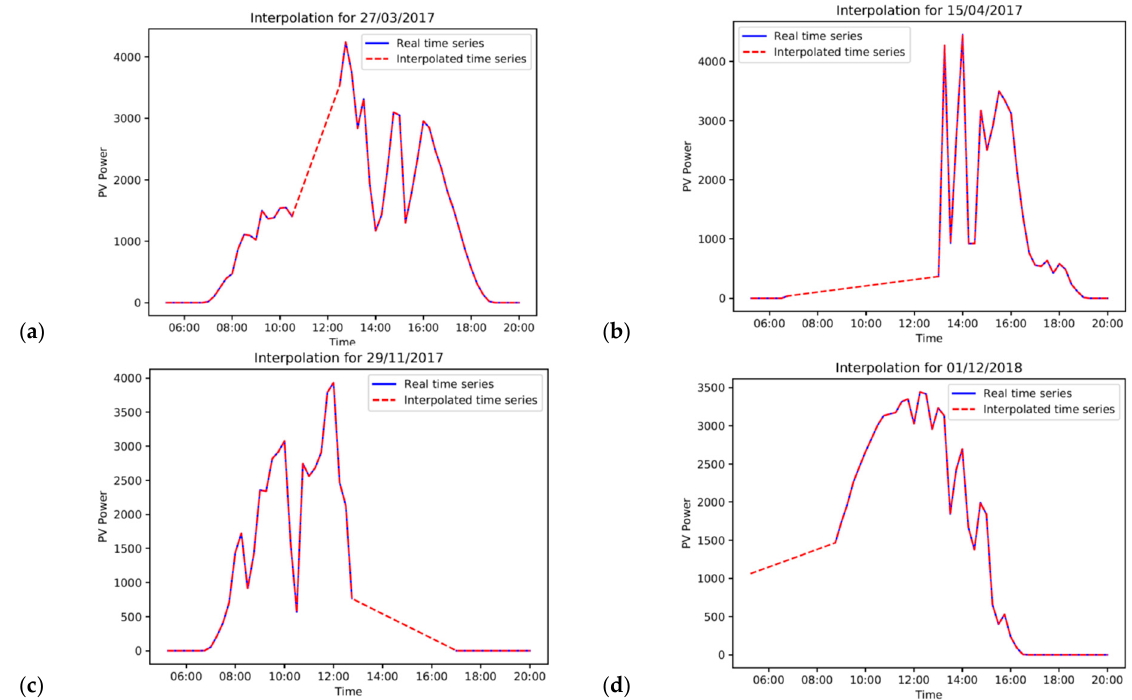
Figure 3. Original and interpolated PV power output time-series for the dates ( a ) 27 March 2017, ( b ) 15 April 2017, ( c ) 29 November 2017, and ( d ) 12 January 2018, for which missing values existed.